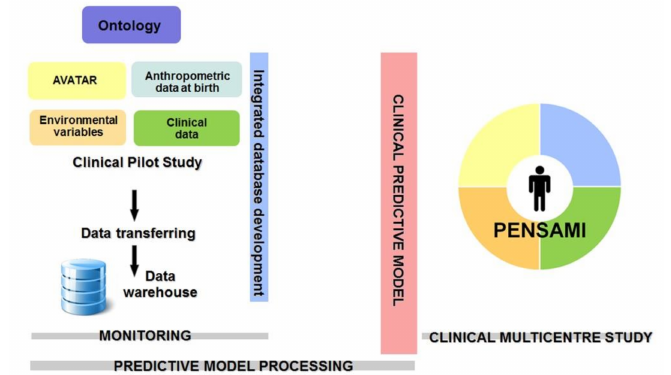
Figure 2. Overall study